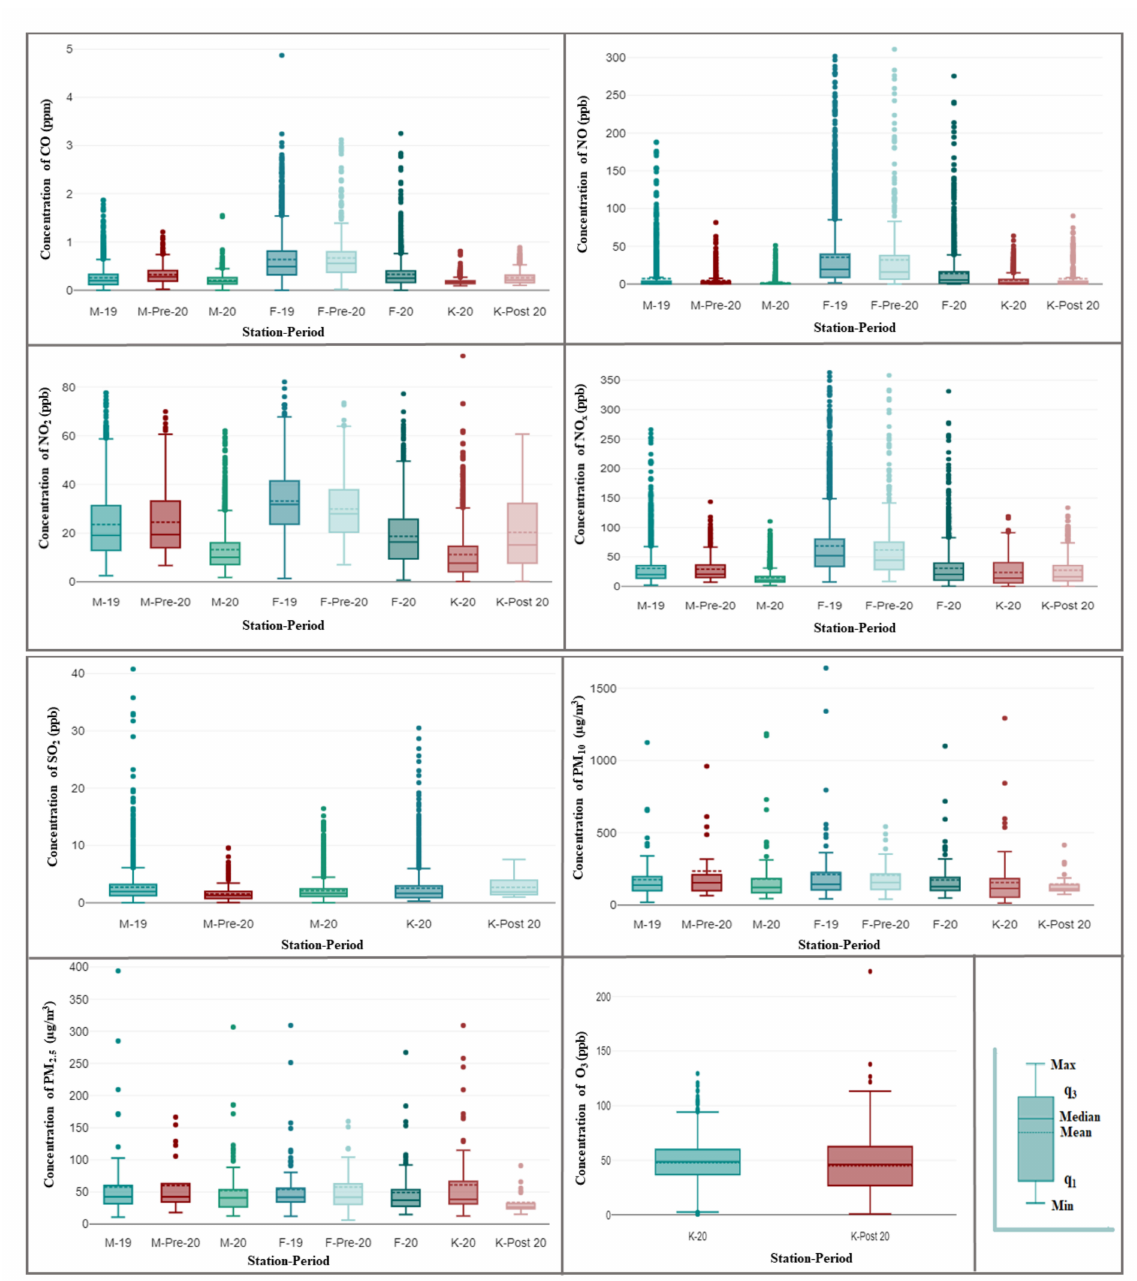
Figure 3. Boxplots of the distributions of 1 h CO, 1 h NO, 1 h NO 2 , 1 h NO x , 1 h SO 2 , 1 h O 3 , 24 h PM 2.5 , and 24 h PM 10 during different periods at three air quality stations (M, F, and